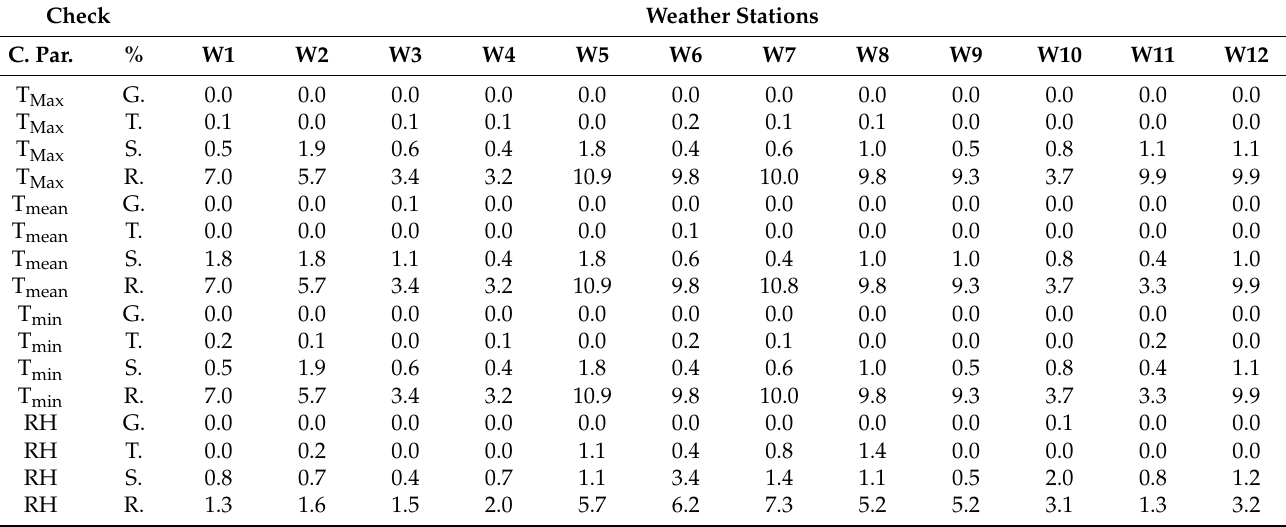
Table 2. Summary of percentages of data deleted after quality checks (G. = gross error checking; T. = temporal consistency; S. = spatial consistency) and percentages of reconstructed data (R. = reconstructed